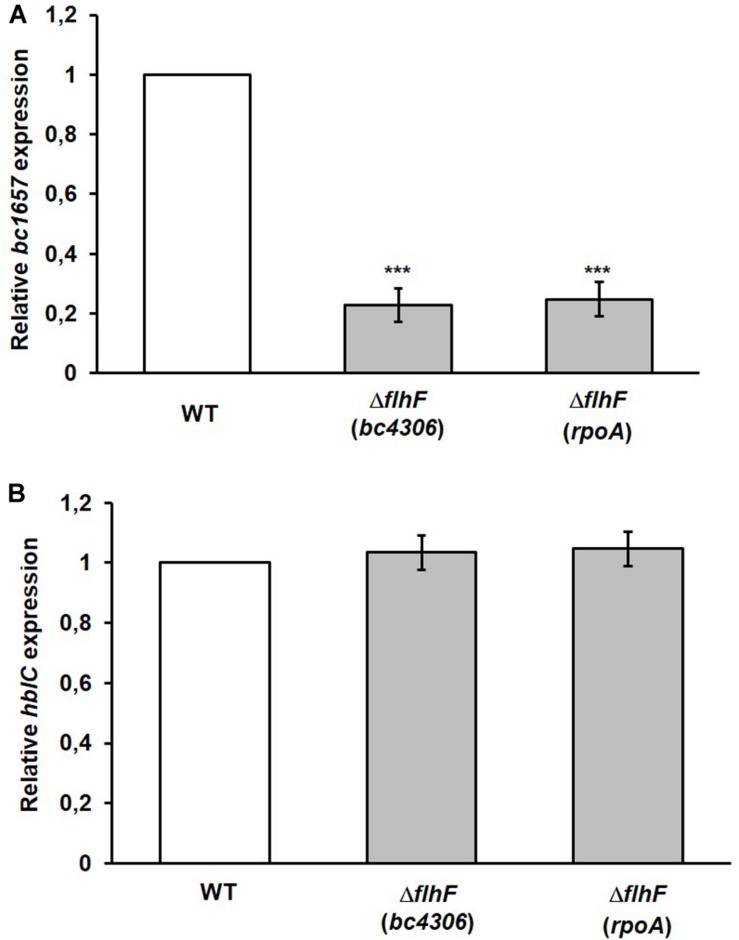
qRT-PCR analysis of the expression of flagellin (bc1657) and L2 (hblC) encoding genes in the ΔflhF mutant. (A) The level of bc1657 expression in the ΔflhF mutant (light gray bars) is presented as fold change relative to the corresponding gene in the WT strain (B. cereus ATCC 14579; white bar). (B) The level of hblC expression in the ΔflhF mutant (light gray bars) is presented as fold change relative to the corresponding gene in the WT strain (B. cereus ATCC 14579; white bar). For both figures, bc4306 and rpoA were independently used as reference genes for normalization. The relative bc1657 and hblC expression in the WT (white bars) is conventionally set to 1. Bars represent means ± S.D. from three independent experiments. ***p < 0.001 compared to the WT.